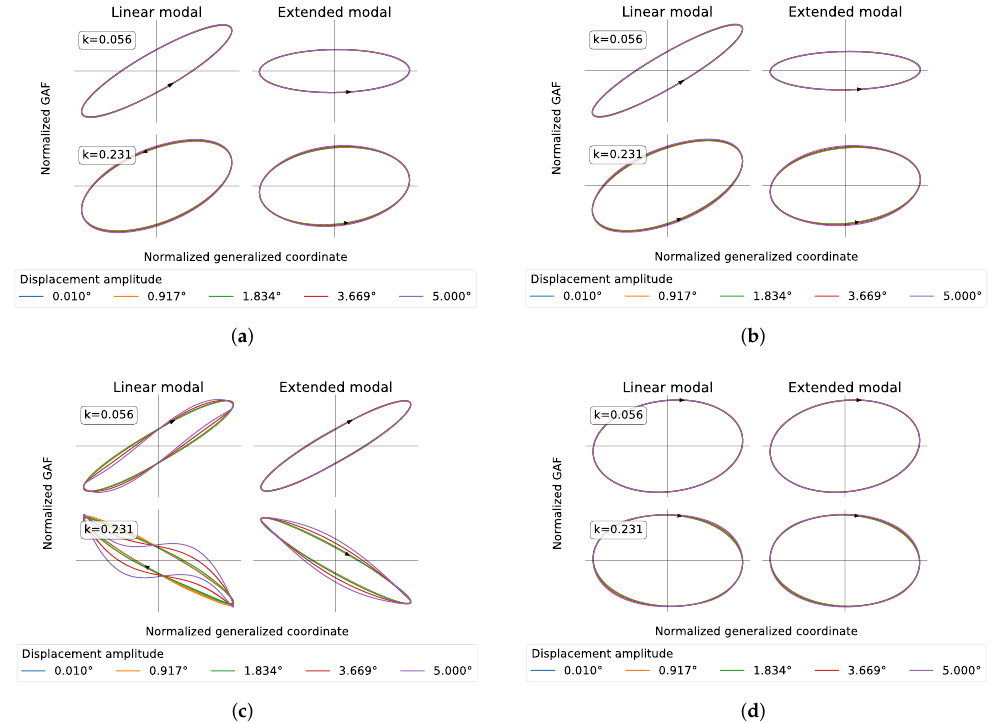
Impact of fluid viscosity on GAF hystereses (Mach 0.4) Figure 14. Impact of fluid compressibility on GAF hystereses (Viscous flow) Figure 12. Figure 14. Impact of fluid compressibility on GAF hystereses (viscous flow). ( a ) Mach 0.4— Q hh ( 1,1 ) ; ( b ) Mach 0.8— Q hh ( 1,1 ) ; ( c ) Mach 0.4— Q hh ( 2,1 ) ; ( d ) Mach 0.8— Q hh ( 2,1 )